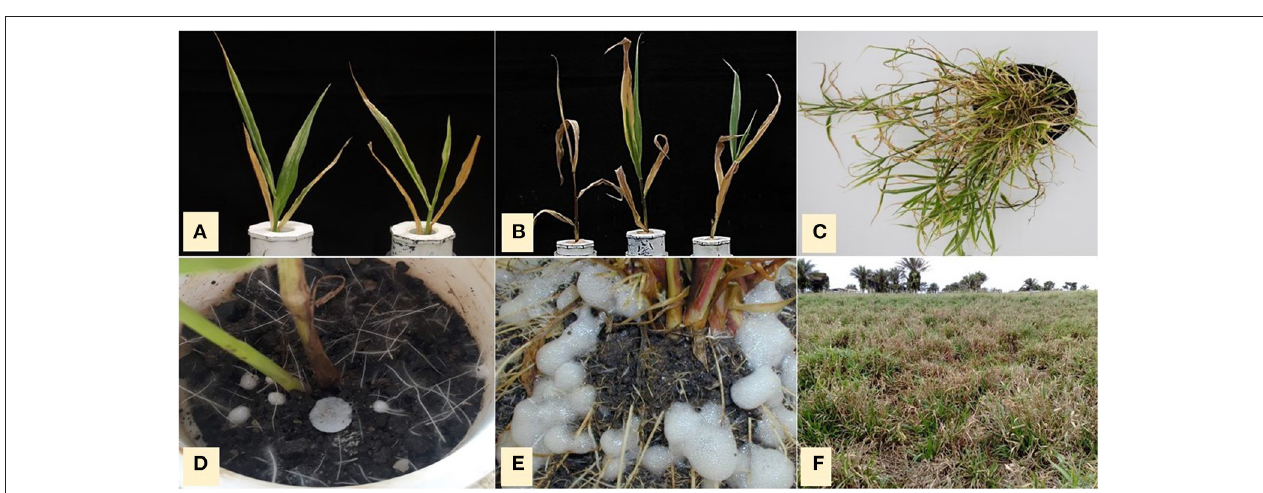
FIGURE 4 | Recognition of spittlebugs. (A–C) : damage characteristic caused by adult and nymph respectively; (D,E) : nymphs coated by their spittle and; (F) : damage caused in fields on grasses. Pictures taken from the archive of the forage entomology laboratory – CIAT.